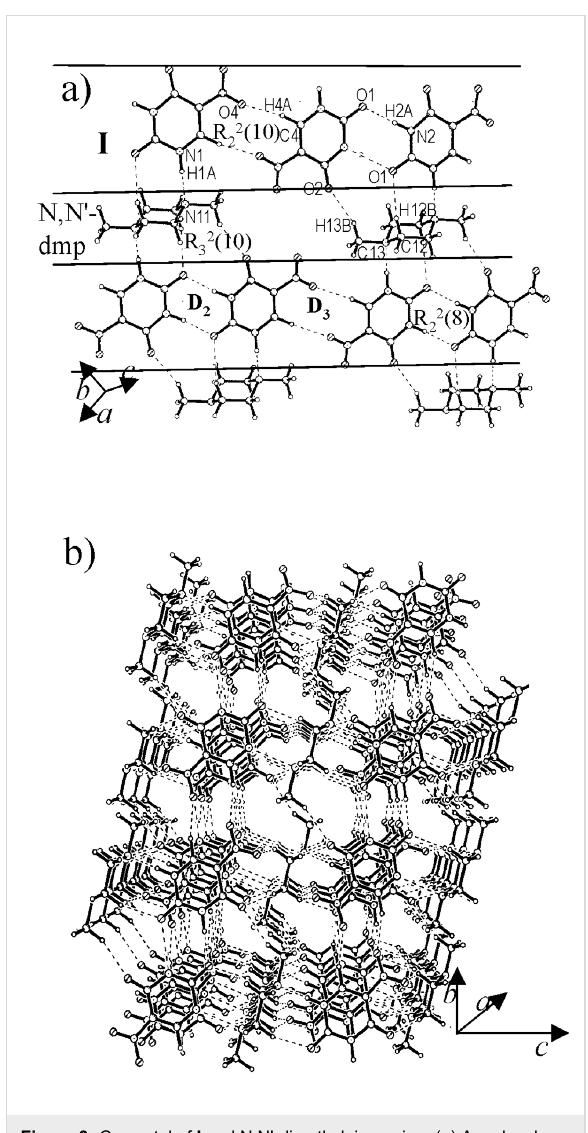
Figure 3: Cocrystal of I and N,N'-dimethylpiperazine: (a) A molecular layer showing alternating chains of I and N,N'-dimethylpiperazine, (b) A view along a -axis showing hydrophobic